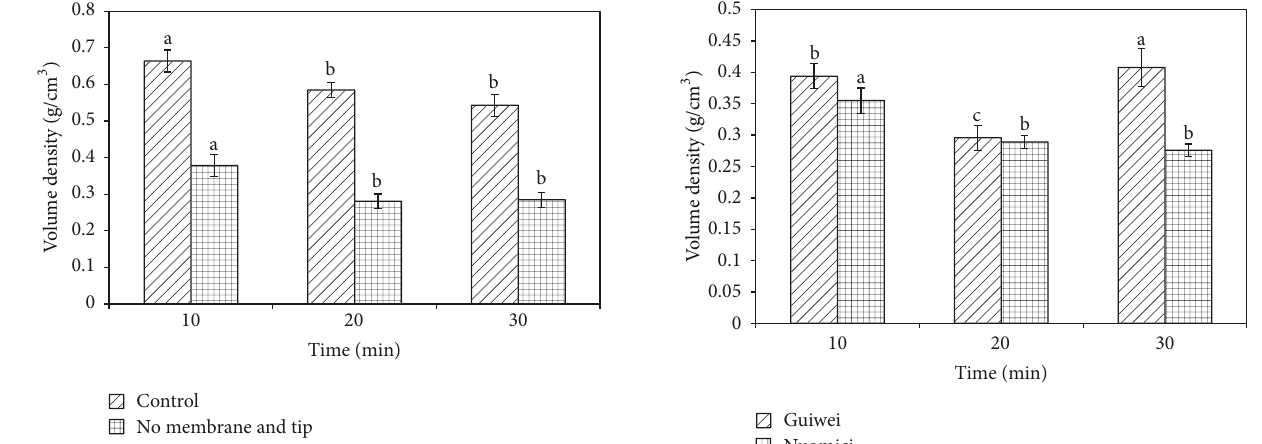
Figure 7: Effect of ultrasound on volume density of FD Guiwei and Nuomicilychee.((a),(b),(c))Valuesinthesamecolumnnotsharing the same superscript are significantly different ( 𝑝 < 0.05